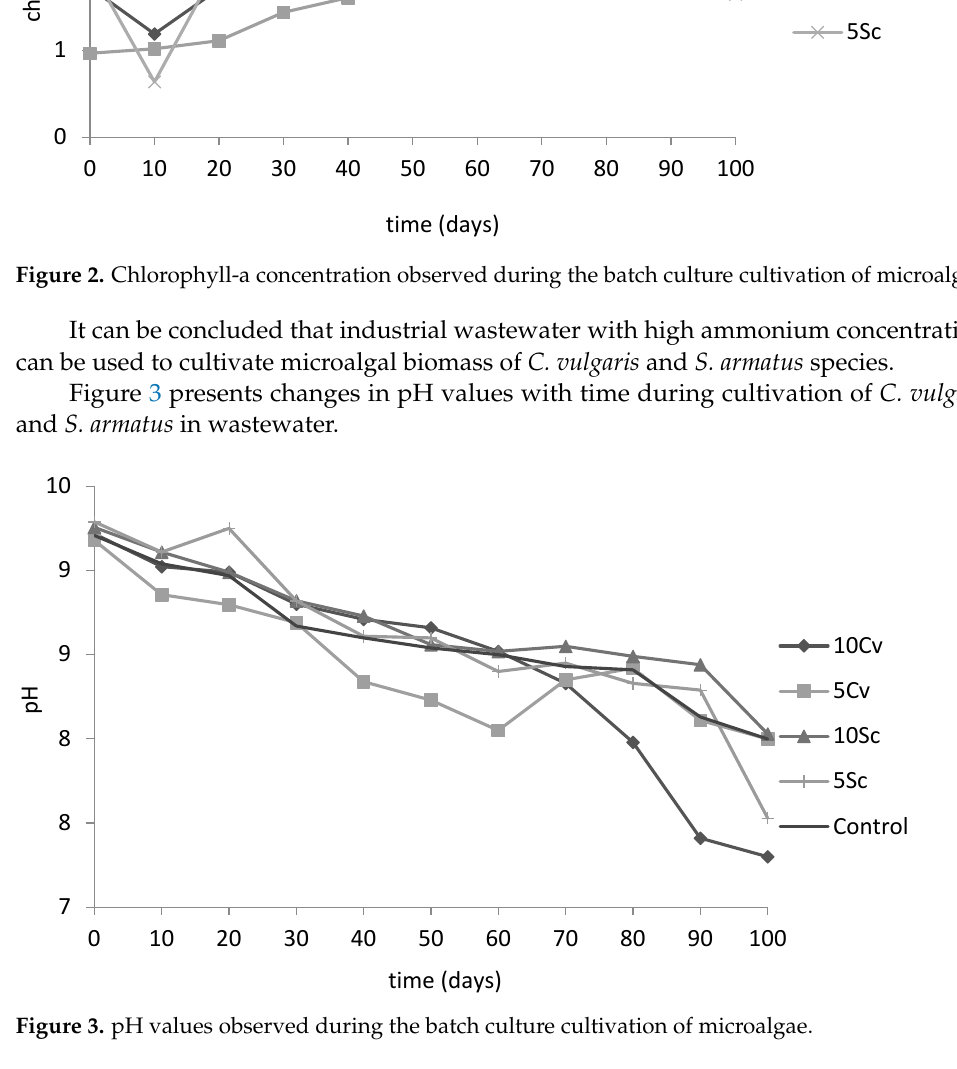
Figure 3. pH values observed during the batch culture cultivation of